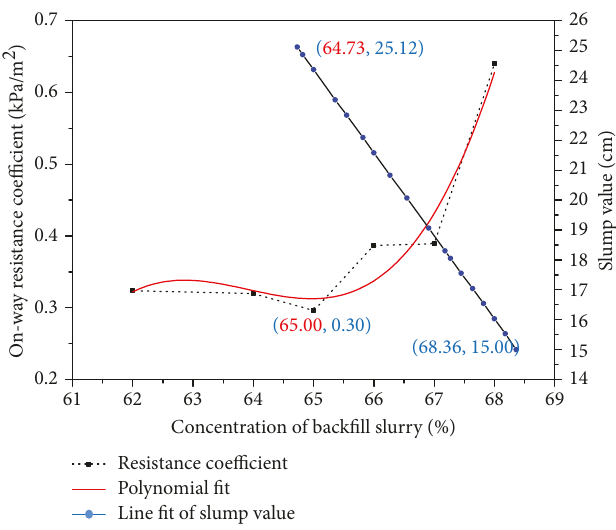
Figure 18: On-way resistance coe ffi cient and slump value.